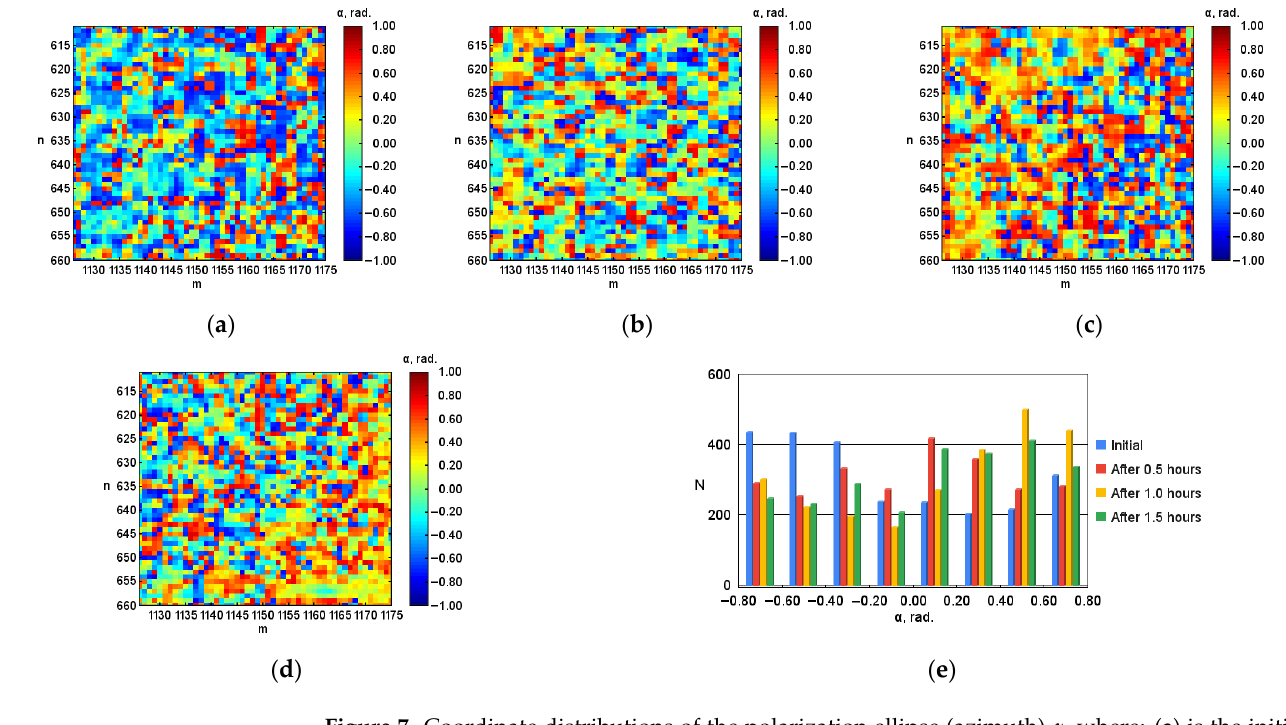
Figure 7. Coordinate distributions of the polarization ellipse (azimuth) α , where: ( a ) is the initial hematocrit level; ( b ) is the hematocrit level after 0.5 h; ( c ) is after 1.0 h; ( d ) is after 1.5 h, and ( e ) the corresponding histograms of the object under investigation.